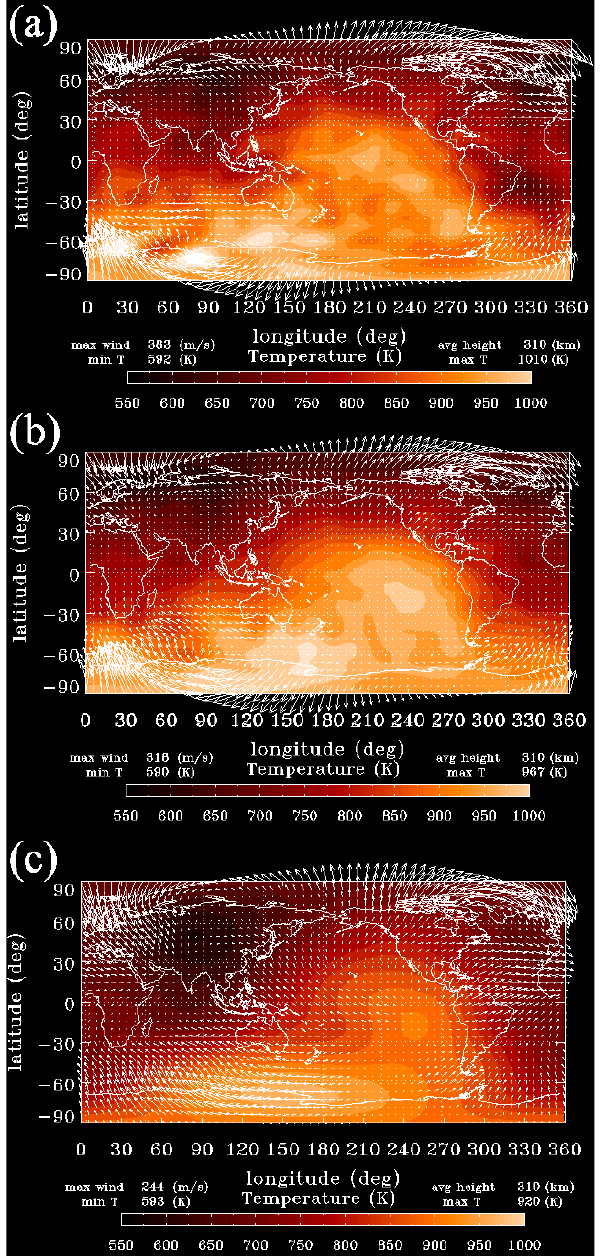
Fig. 2. The global distributions of temperature and horizontal wind obtained from (a) GCM calculations on a constant-pressure surface ( ∼ 310km altitude) at 01:00UT on 1 December, (b) 5-day averages of GCM calculations at 01:00UT, and (c) the NRLMSISE-00 and HWM-93 empirical models. Note that the strength of the maximum wind vector is different in each panel.